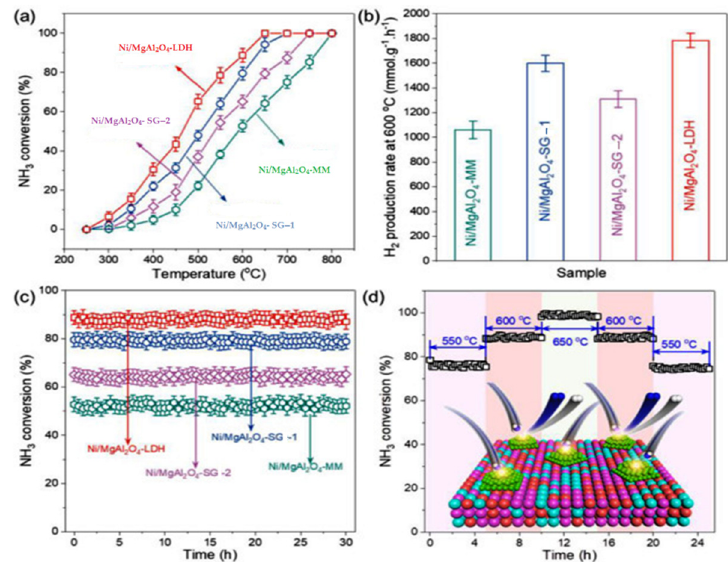
Figure 34. The process of ammonia decomposition over a La-based catalyst consists of calcined nickel and cobalt [131].